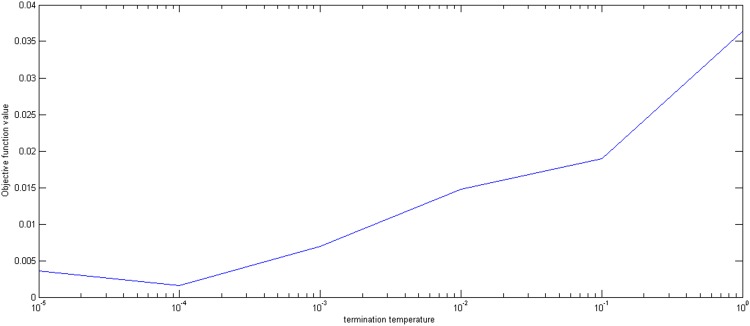
The effect of termination temperature on the objective function value.